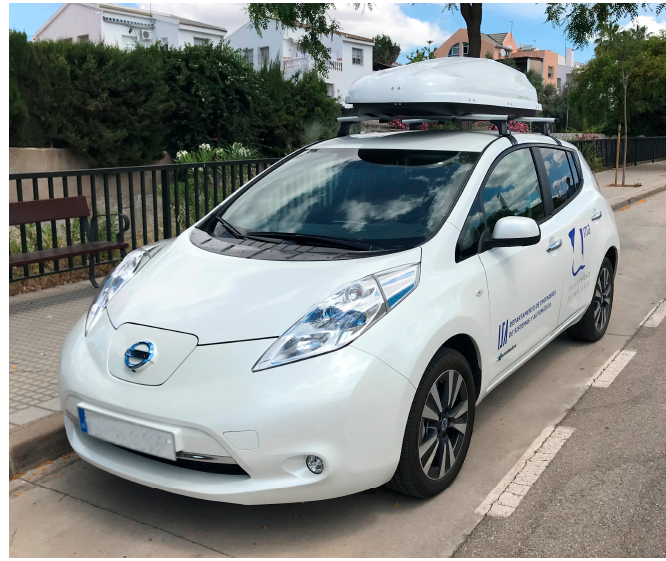
Figure 11. Vehicle used in experiments showing the top case with the UIS Mobile node installed.